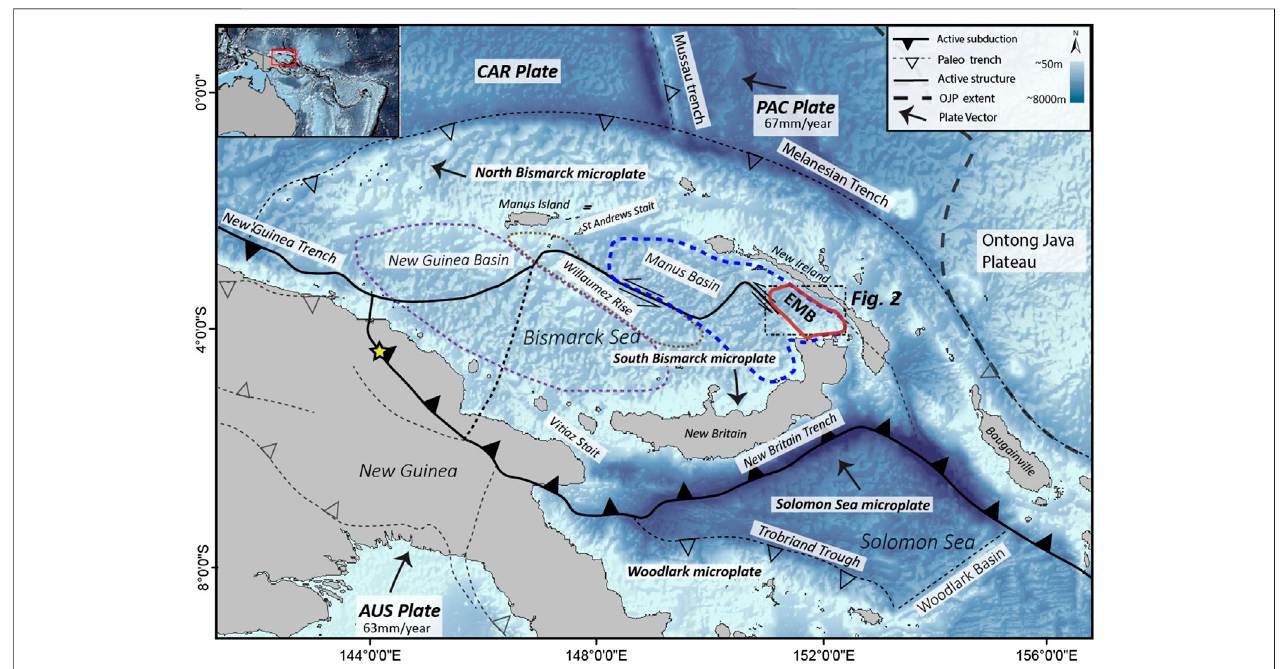
FIGURE 1 | Geological setting of the New Guinea-Solomon Islands region (After Bird, 2003; Wallace et al., 2004; Holm et al., 2016). EMB outlined in red polygon, Manus Basin outlined with blue dashed polygon, Willaumez Rise outlined with brown dashed polygon, and the New Guinea Basin outlined by purple dashed polygon. Microplatemotion basedon GPSvectorsoftheNew Guinea region(Wallace etal., 2004).Yellowstarindicates poleofrotationoftheAUS – South BismarckMicroplates. Arrowsindicate plate motion based on Euler vectors of the best fi t model (Wallace et al., 2004). Bathymetry derived from General Bathymetric Chart of the Oceans (GEBCO, Weatherall et al., 2015) – IOC, IHO, and BODC, 2003, “ Centenary Edition of the GEBCO Digital Atlas ” , Intergovernmental Oceanographic Commission and the InternationalHydrographicOrganizationaspartoftheGeneralBathymetricChartoftheOceans;BritishOceanographicDataCenter,Liverpool – https://www.gebco.net/ data_and_products/gridded_ bathymetry_data/gebco_30_second_grid/.